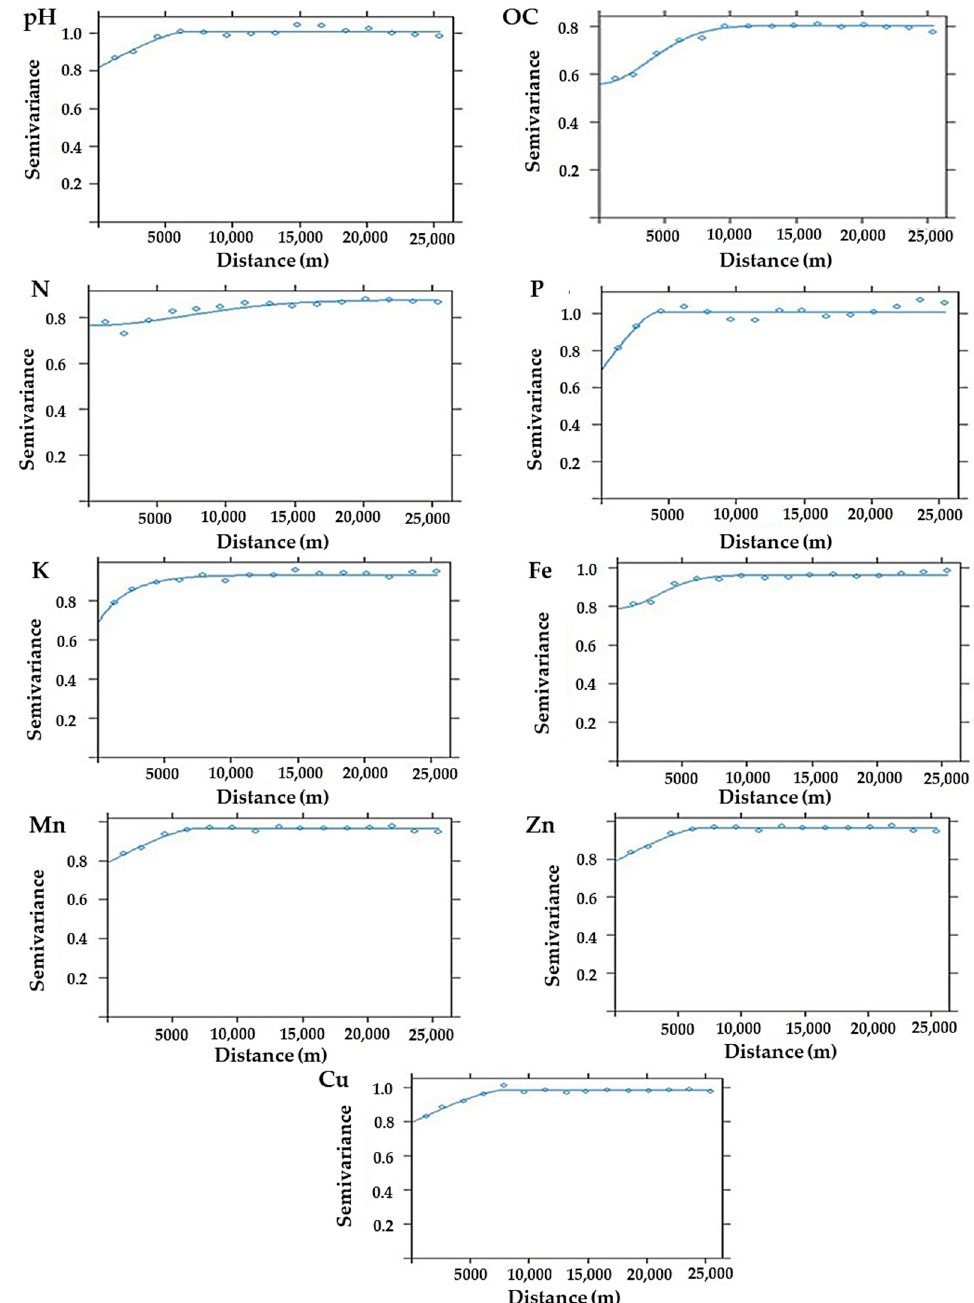
Figure 3. Semivariograms of residuals were calculated, with the lines showing the best-fit model based on the RMSE and R 2 values. pH; OC, soil organic carbon; N, available nitrogen; P, available phosphorus; K, available potassium; Fe, Mn, Zn and Cu represent DTPA-extractable iron, manganese, zinc and copper in soil, respectively.